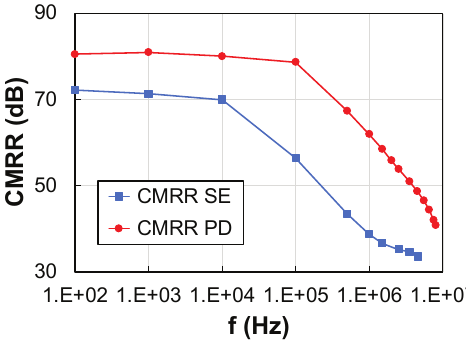
Figure 10. Experimental response of the CMRR as a function of the frequency.